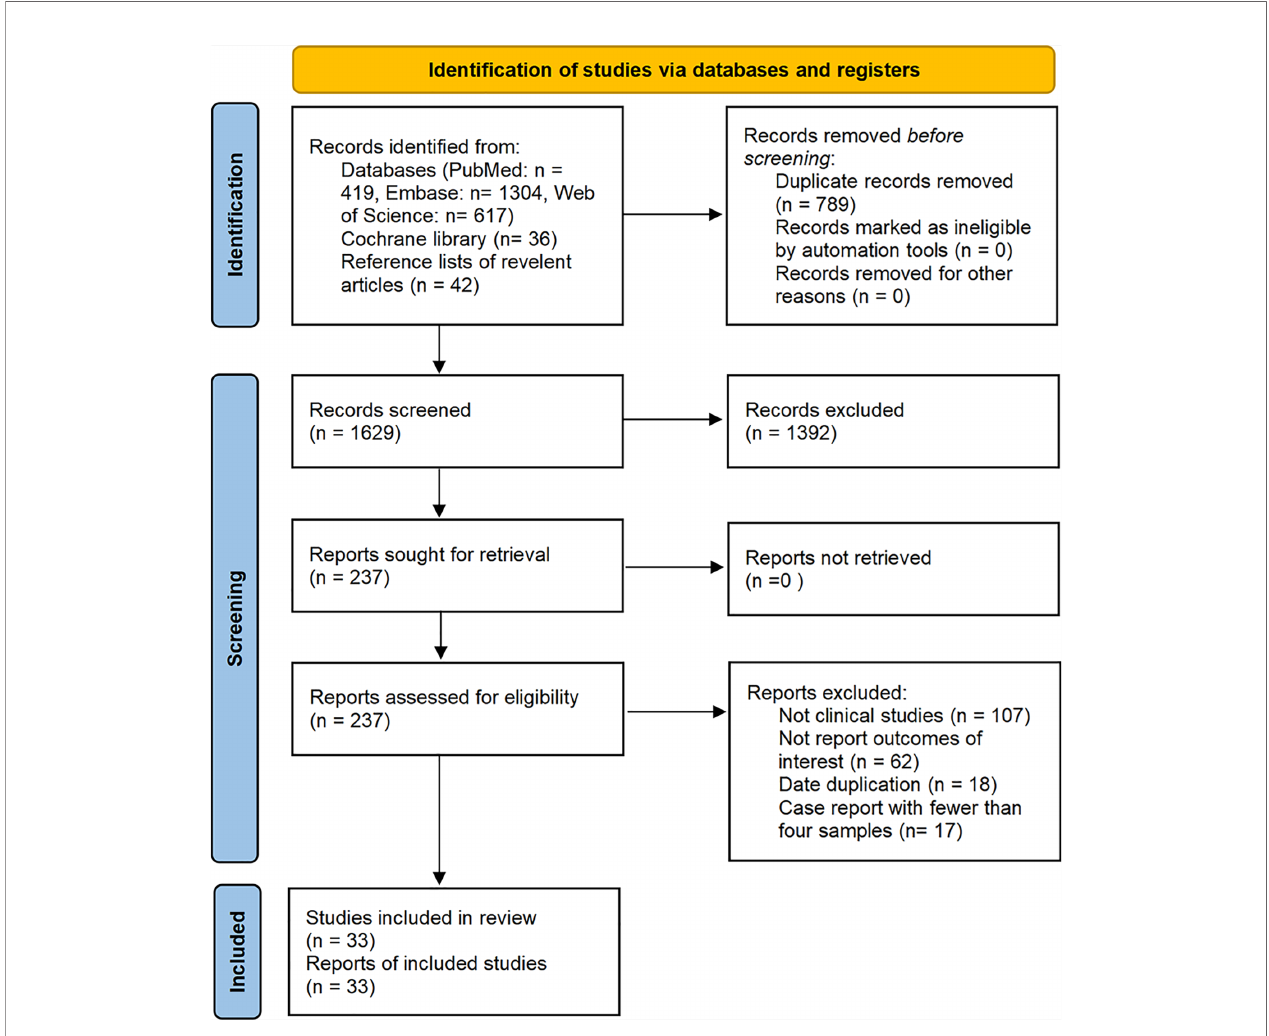
FIGURE 1 | Flow diagram of the study select